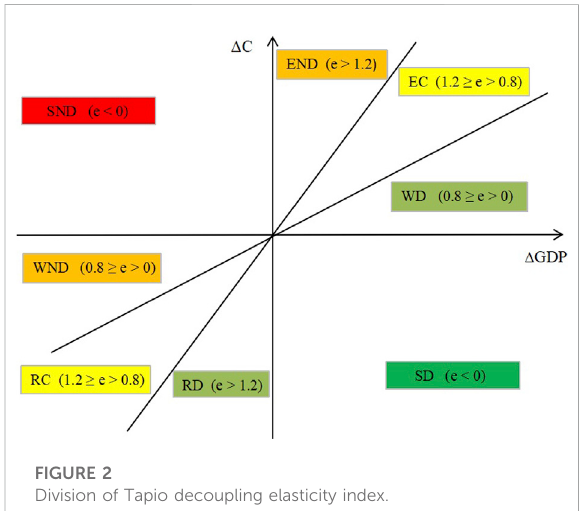
FIGURE 2 Division of Tapio decoupling elasticity